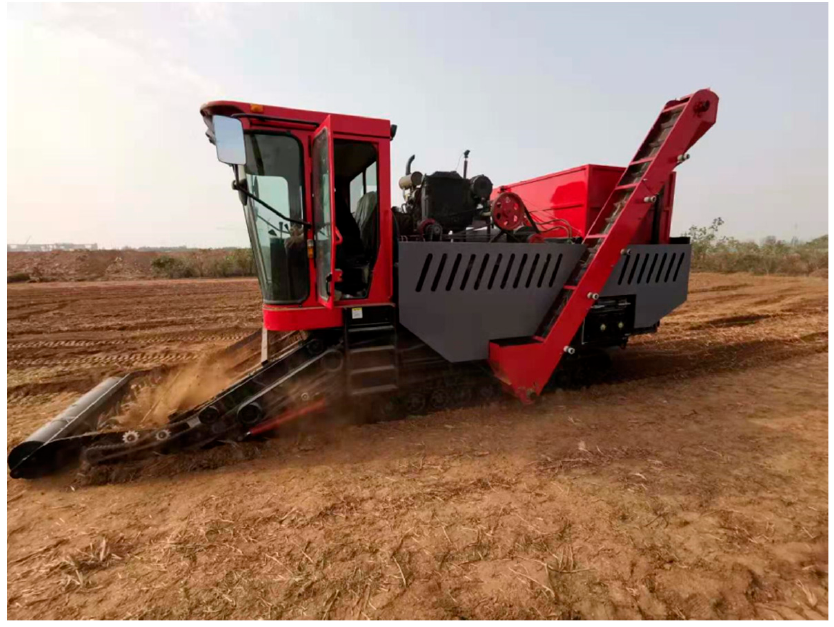
Figure 11. Field tests.